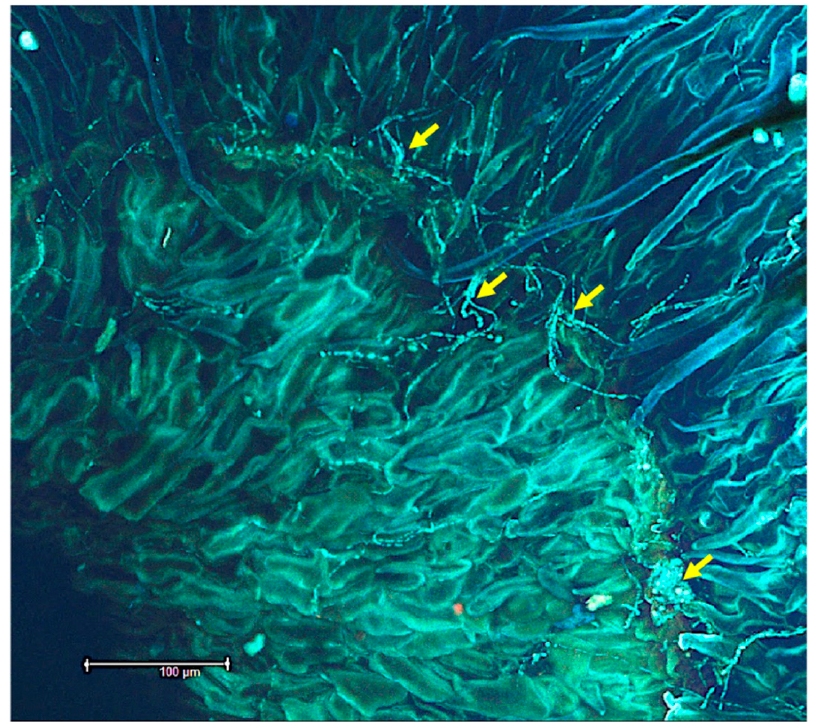
Figure 3. Fluorescent laser scanning confocal image shows fine threads of mycelia of the Chaetothy- riales symbiont around the closed seed hilum of Ipomoea riedelii indicated by the arrows. Scale bar— 100 μ m.